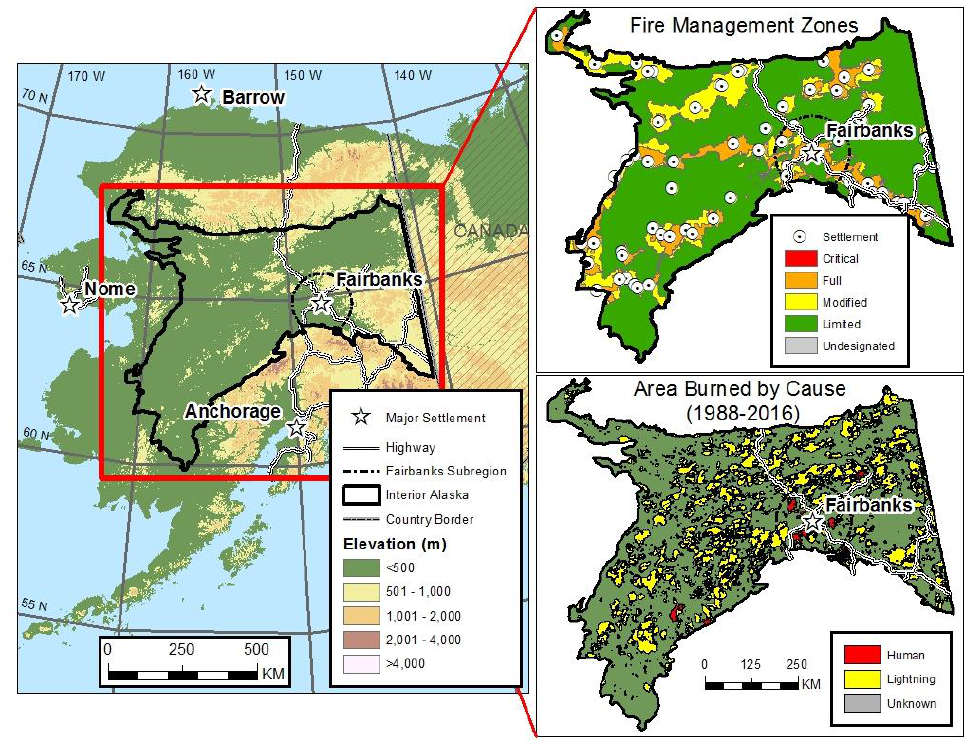
Figure 1. Delineation of interior Alaska and the Fairbanks subregion, location of designated fire management zones, area burned by cause between 1988 and 2016, and other relevant geographic information.